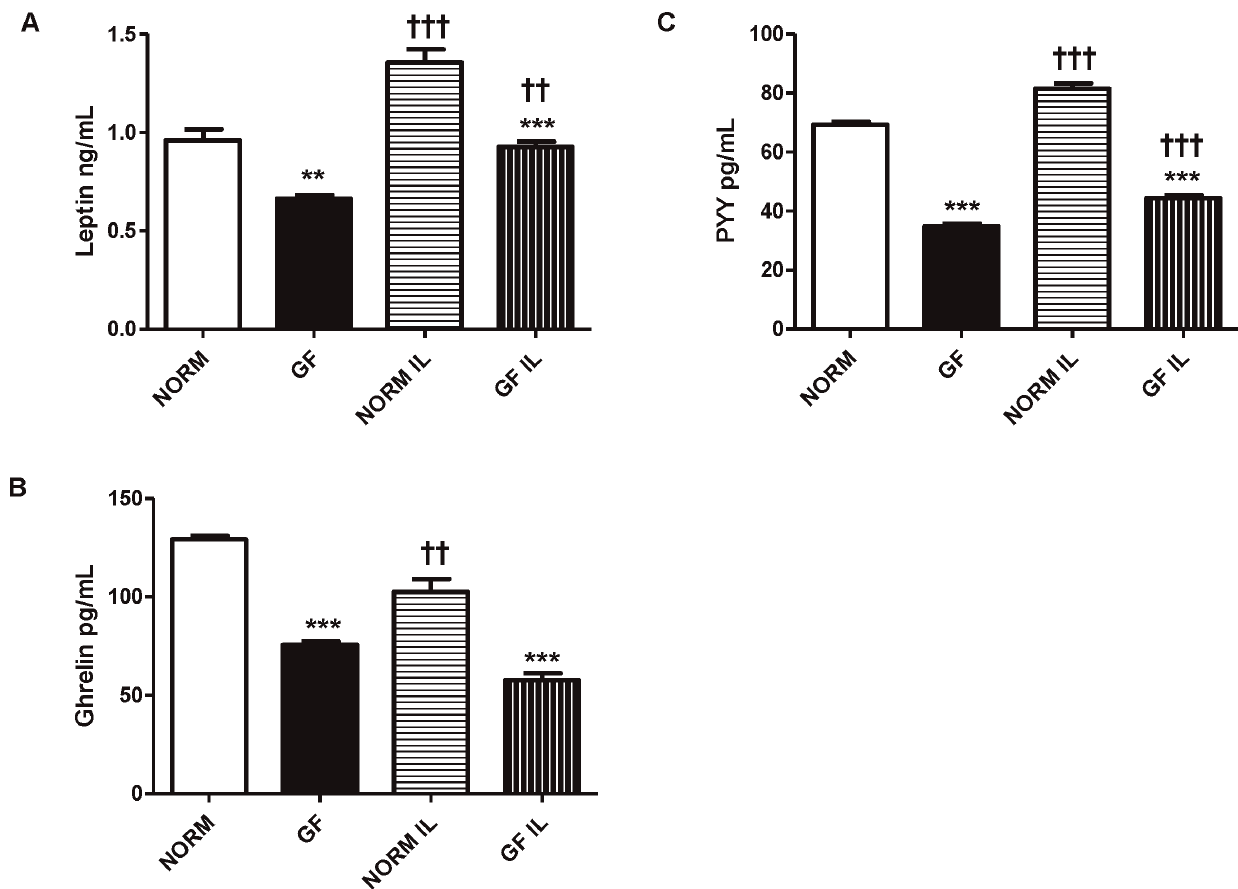
Figure 6. Plasma levels of (A) leptin, (B) ghrelin, and (C) PYY in GF and NORM mice following an overnight fast or re-feeding with 1- ml of 20% intralipid. (A) Plasma leptin was lower in GF mice relative to NORM controls. Re-feeding elevated plasma leptin in both groups. (B) GF mice displayed lower levels of plasma PYY compared to NORM mice while re-feeding increased plasma PYY in both groups. (C) GF mice exhibited lower circulating of ghrelin in both feeding conditions while re-feeding increased plasma ghrelin in NORM, but not GF mice. Data are expressed as means 6 SEM. **P , 0.01 ***P , 0.001, compared to NORM mice. {{ P , 0.01, {{{ P , 0.001, compared to fasting condition within group.